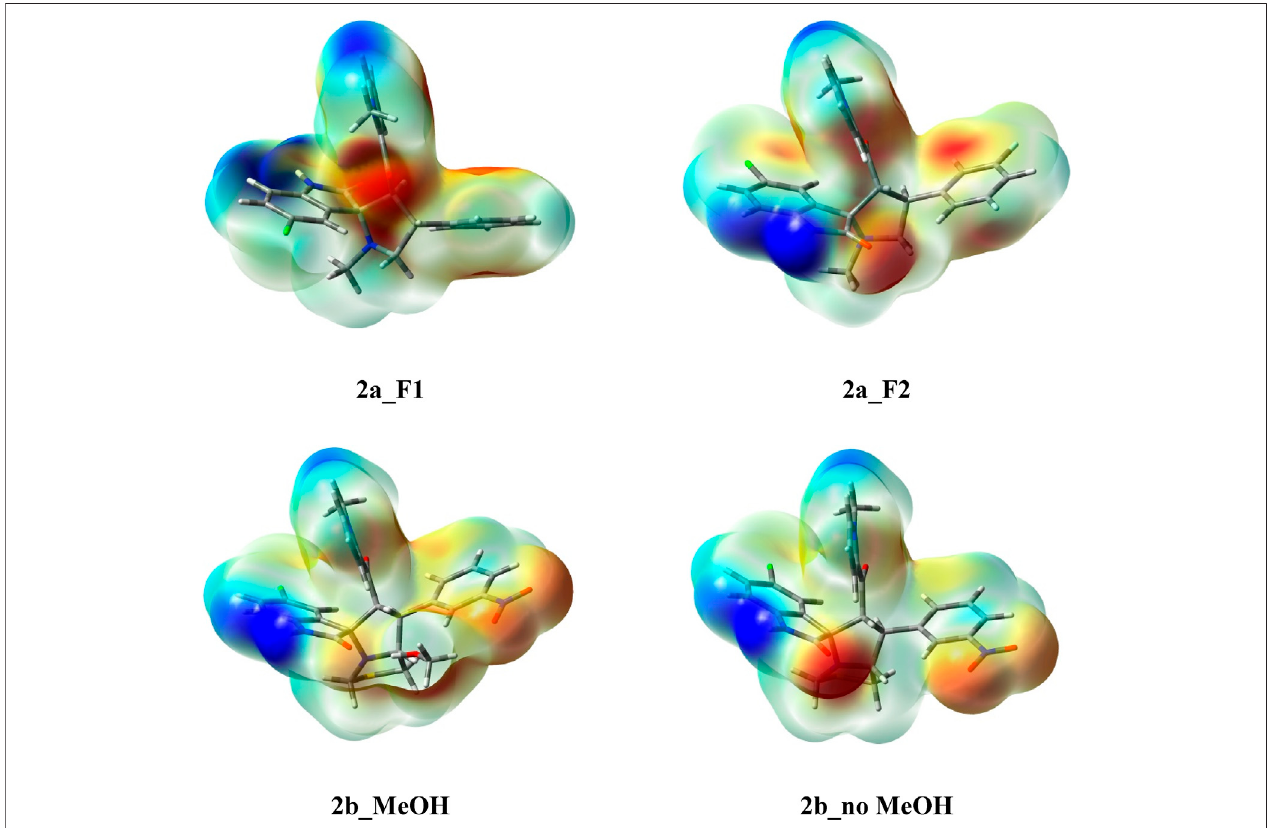
FIGURE 8 | The molecular electrostatic potential (MEP) maps of the studied compounds. The color index from blue to turquoise to yellow to red indicat the more negative electron density.